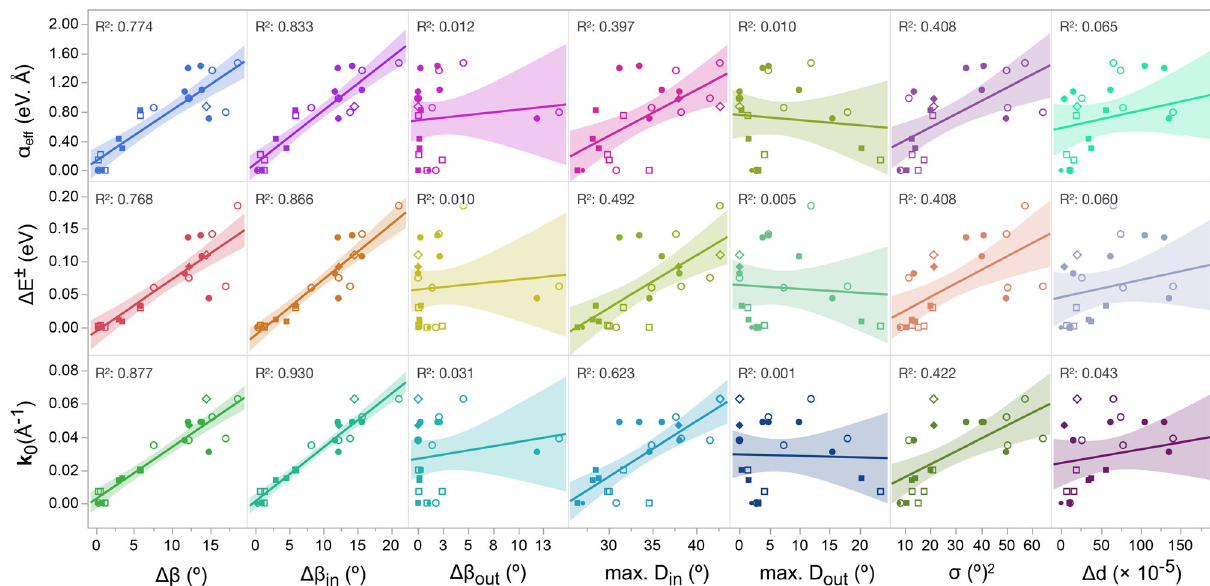
Fig. 5 Structural correlations of spin-splitting in 2D MHPs. Correlations between various inorganic layer distortions and predicted spin-splitting parameters ( Δ E ± ; k 0 , and α eff ) in select chiral and achiral MHPs with experimental and with computationally relaxed geometries (Table 1). Data points corresponding to X = Cl, Br, and I are denoted with diamonds, circles, and squares, respectively. The fi lled and open symbols denote, respectively, the experimental and relaxed MHP atomic con fi gurations. The solid lines are fi ts to a linear regression model, and the corresponding R 2 values and 95% con fi dence intervals (shaded regions) are shown in each subplot. Δ β , Δ β in , and Δ β out denote the asymmetric interoctahedral distortions, whereas Δ d and σ 2 denote the intraoctahedral distortions (see the main text for details). “ max. D in ” and “ max. D out ” denote, respectively, the maximum in-plane ( D in ¼ 180 (cid:4) (cid:3) β in ) and out-of-plane ( D out ¼ 180 (cid:4) (cid:3) β out ) distortion values corresponding to smaller β in and β out angles within the inorganic